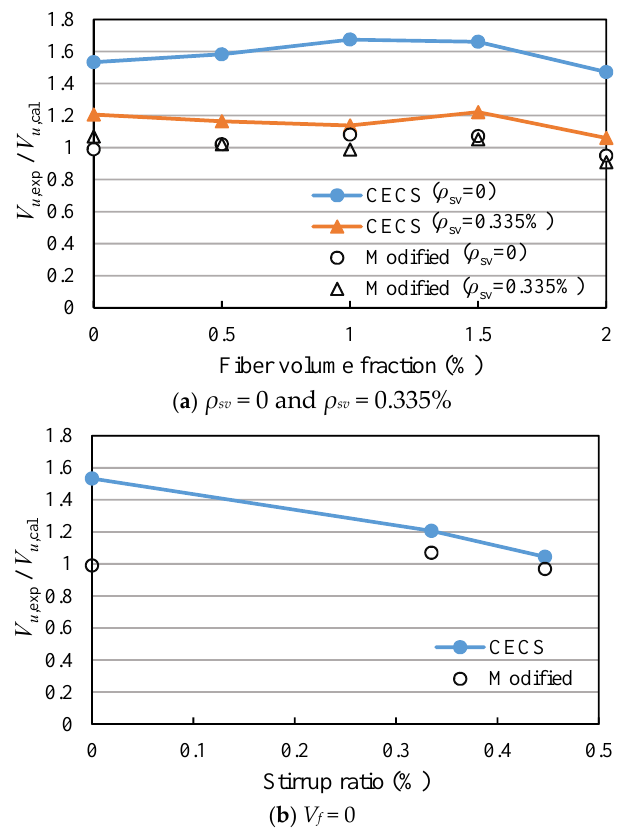
Figure 12. Comparison of test value and calculation value of CECS38:2004. ( a ) The test beams with stirrup ratio 0 and 0.335%; ( b ) The test beams without steel fiber.